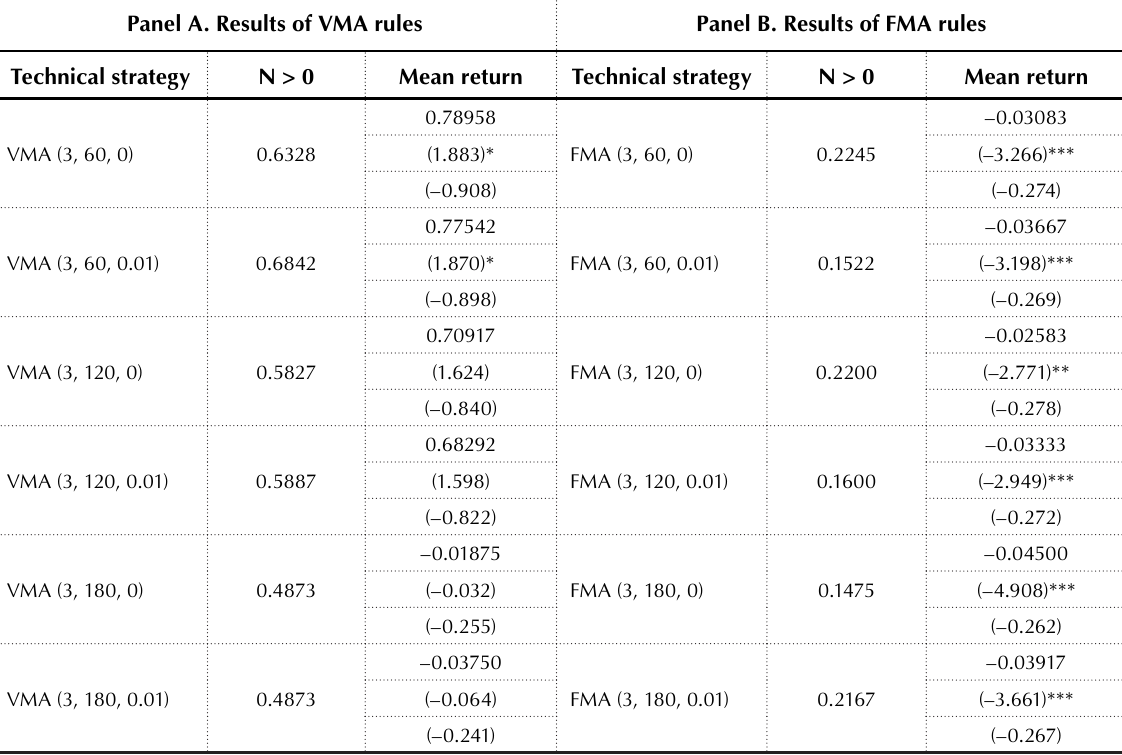
Table 2. VMA and FMA trading performance during the global financial crisis (2008–2009) Panel A. Results of VMA rules Panel B. Results of FMA